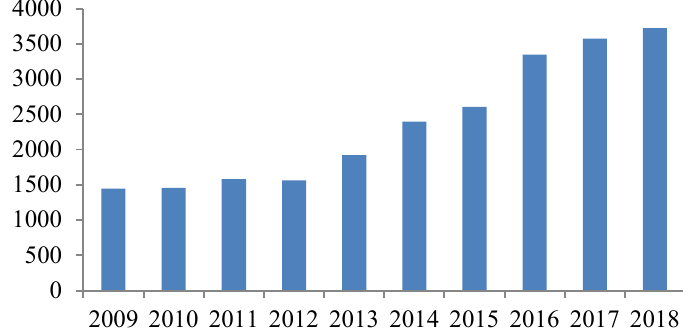
Fig. 2. Production of biofuels and energy from waste, thousands of tons of conventional oil (Palyvno-enerhetychni,